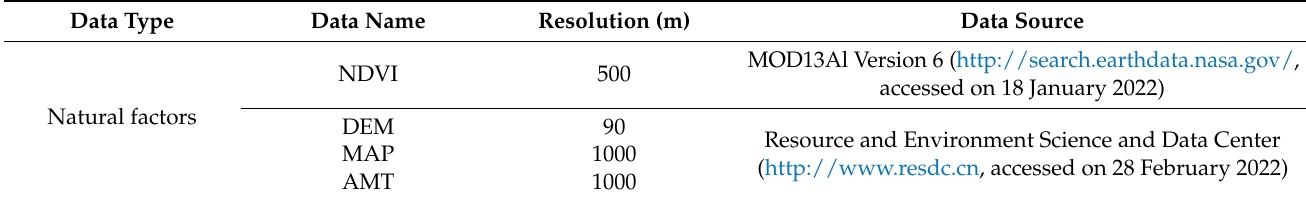
Table 1. The land-use drivers and data